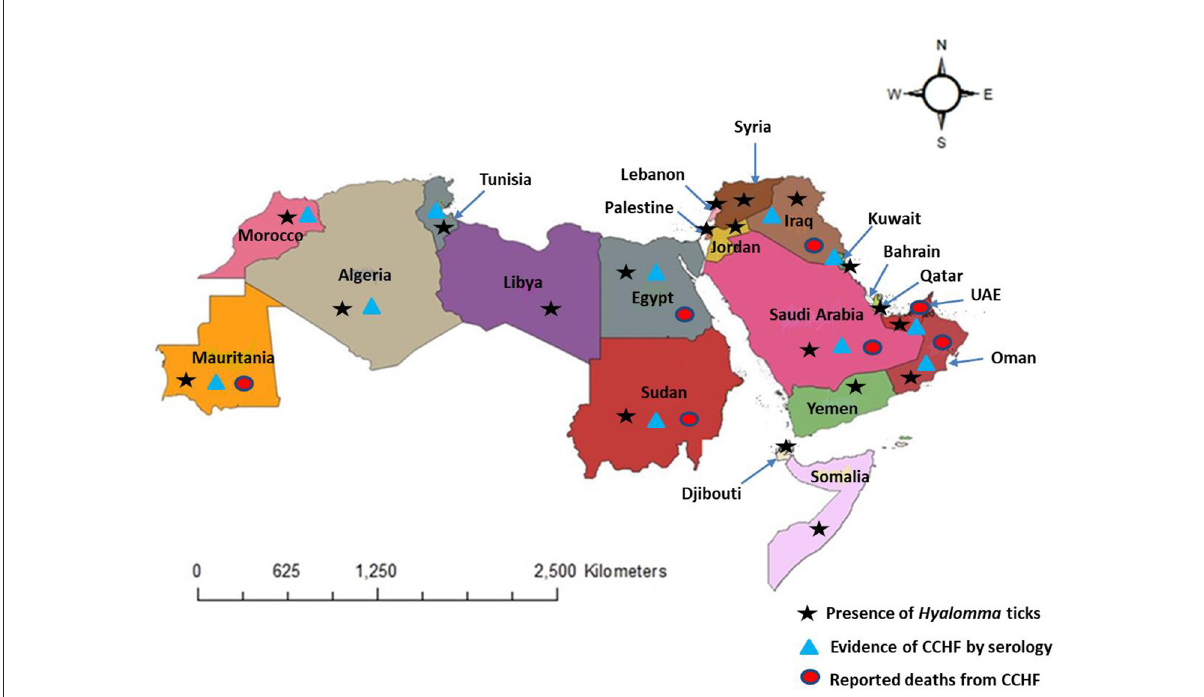
FIGURE2 Distribution of Hyalomma ticks, evidence of CCHF, and reported deaths from CCHF in the Arab world (map is reproduced published under the Creative Commons Attribution 4.0 International (CC BY 4.0) License in our study, Perveen et al. (4).